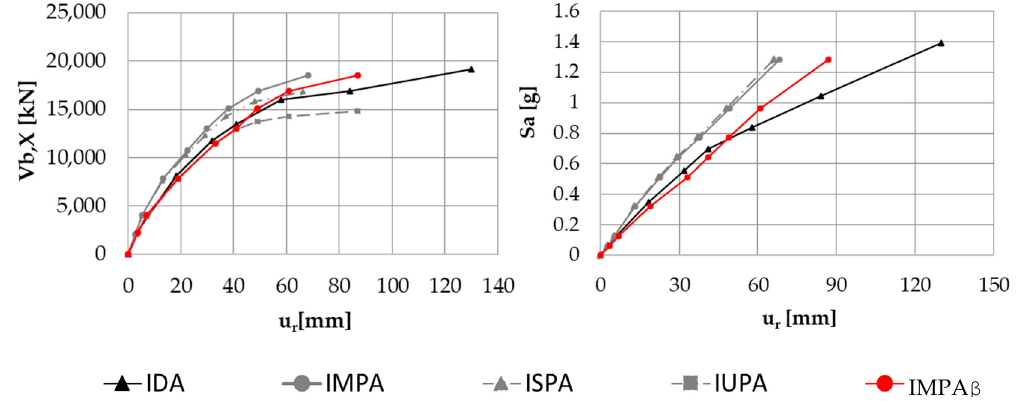
Figure 23. Case study—incremental curve (displacement-intensity) and capacity curves derived with IDA (maximum values of ur and Vb,x) or IMPA β (the design PGA was 0.35 g, corresponding to a transversal base shear of V b,x ~ 13,000 kN).